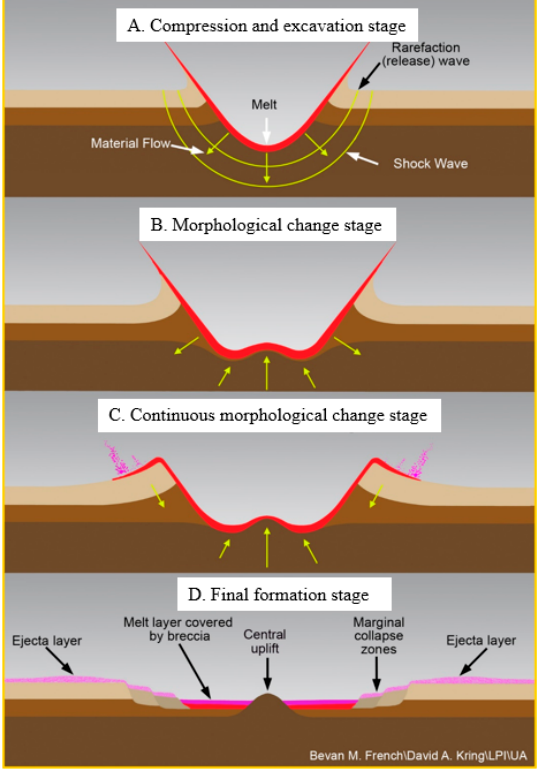
Figure 1. Formation process of an impact crater (modified from [48]).